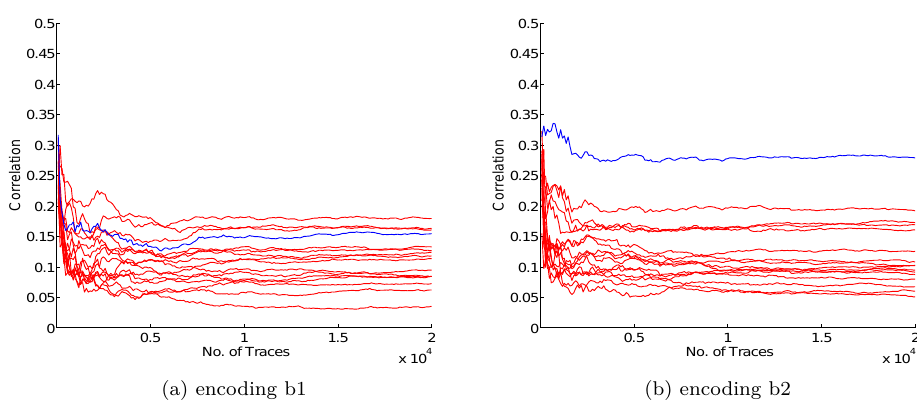
Figure 8: CPA on encoded traces, blue line indicating correct key hypothesis and red lines indicating the wrong key